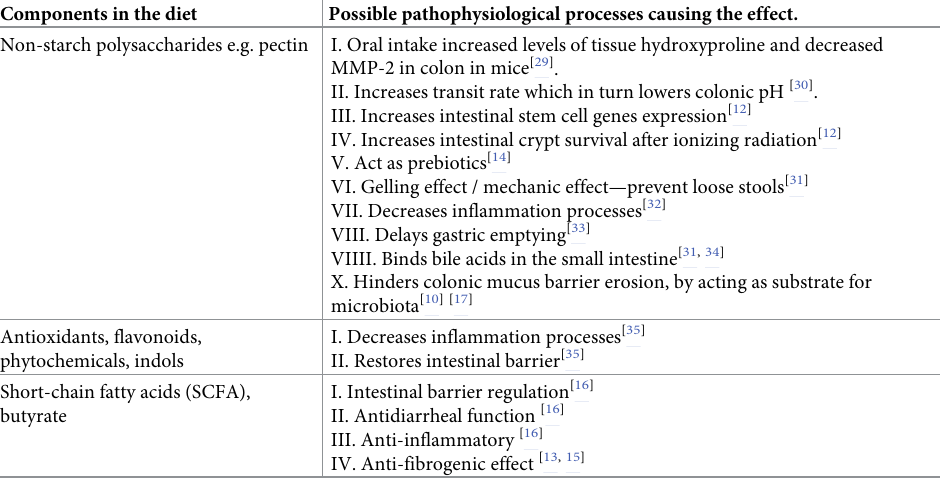
Table 4. Components in the diet and their possible pathophysiological processes causing the effect on radiation- induced survivorship symptoms. Components in the diet Possible pathophysiological processes causing the